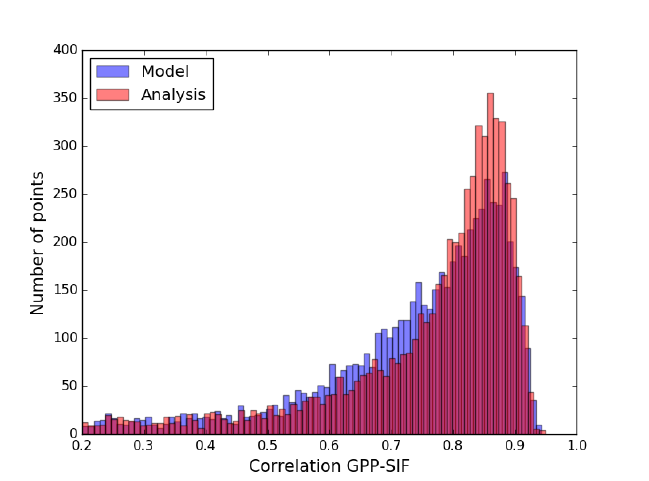
Figure 9. Histogram of correlation values from Figure 8 between the SIF observations and the GPP simulations (open-loop in blue and analysis in red).